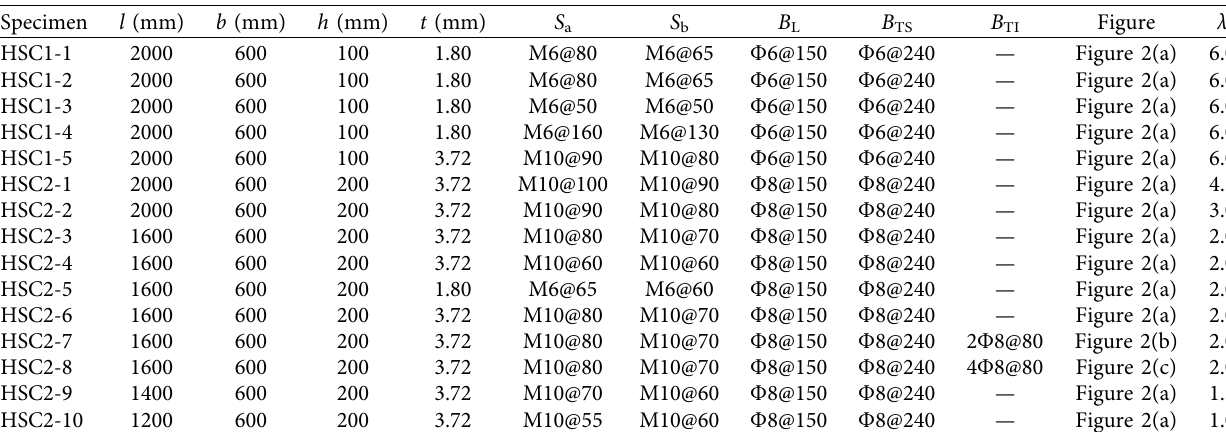
Table 1: Design parameters of the specimens.